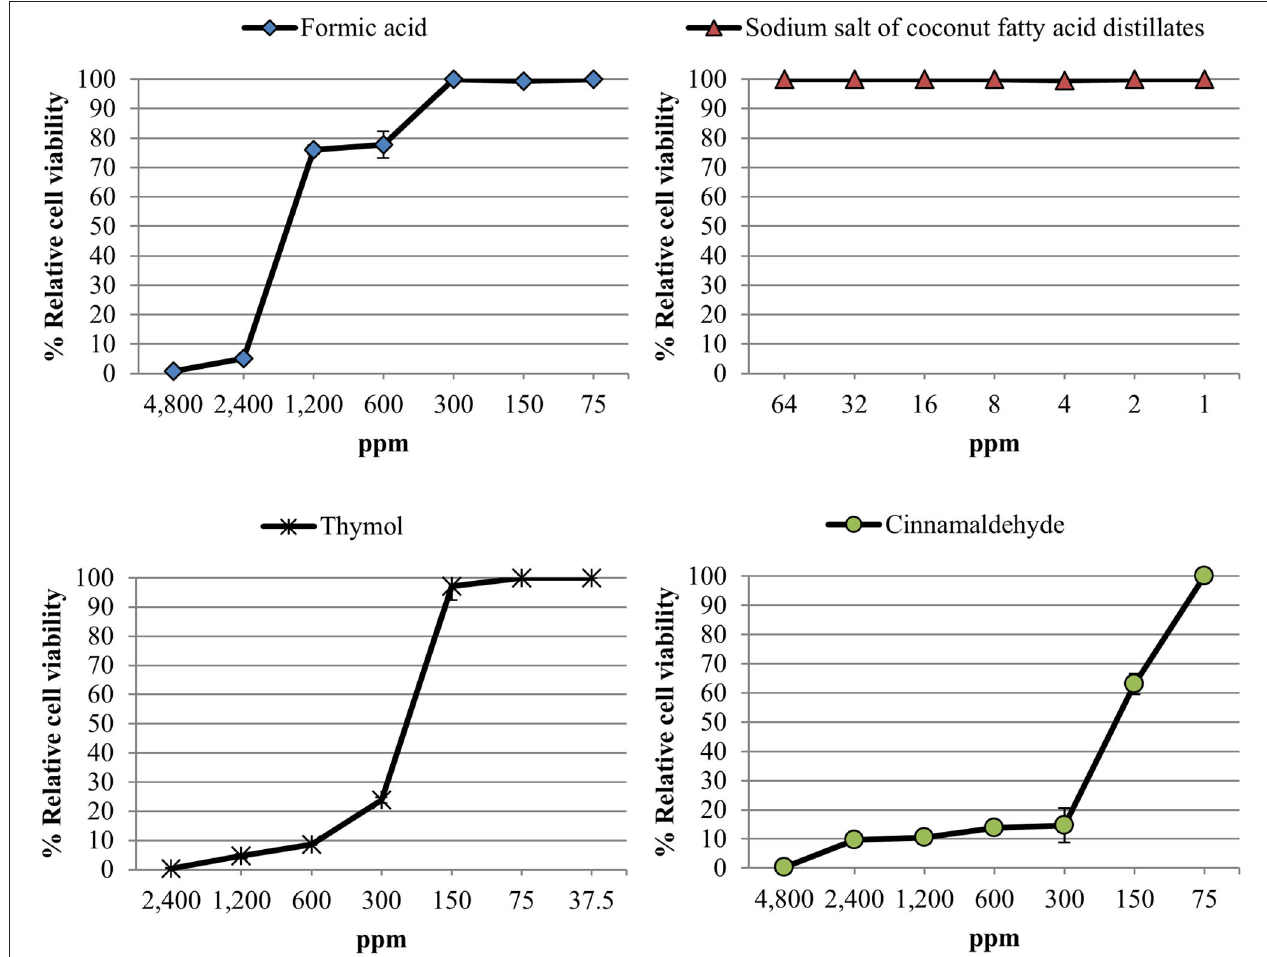
FIGURE 1 | Relative cell viability rate [(mean fluorescence of treated well/mean fluorescence of control well) × 100] measured using an alamarBlue assay after exposure of Vero cell monolayers for 48h to different concentrations of each compound tested. Data are expressed as mean of the three independent replicates ± standard